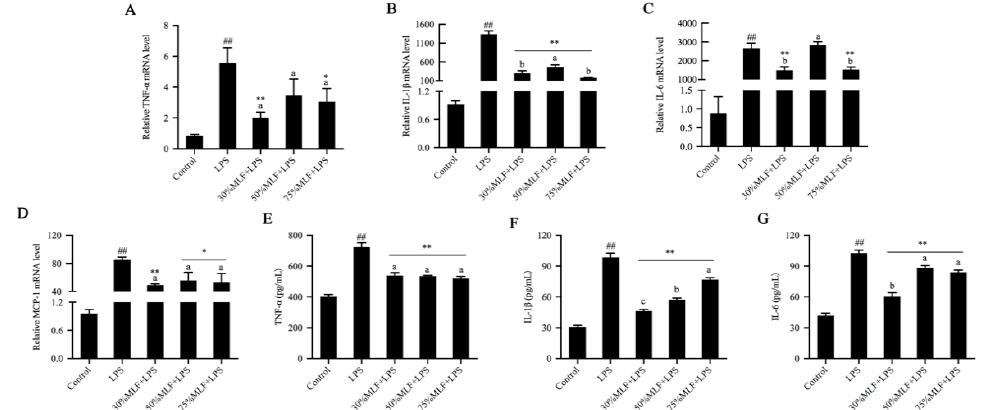
Figure 3. Effects of MLFs on inflammatory cytokine secretion in LPS ‐ induced RAW 264.7 cells. The